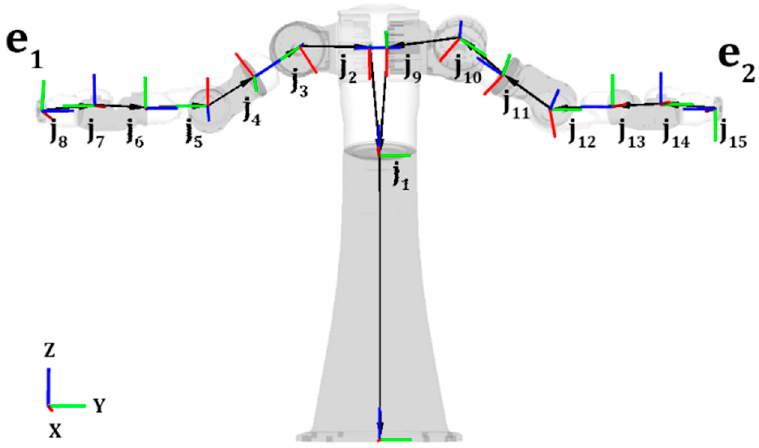
Figure 2. Torso robot joint and link tree using Motoman SDA20D URDF in RViz [22]. J i represents joints, e i represents end effectors.